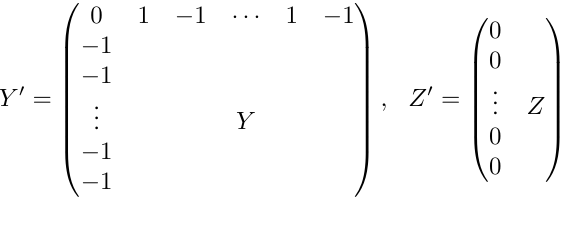
Fig. 3: The matrices Y (cid:48) and Z